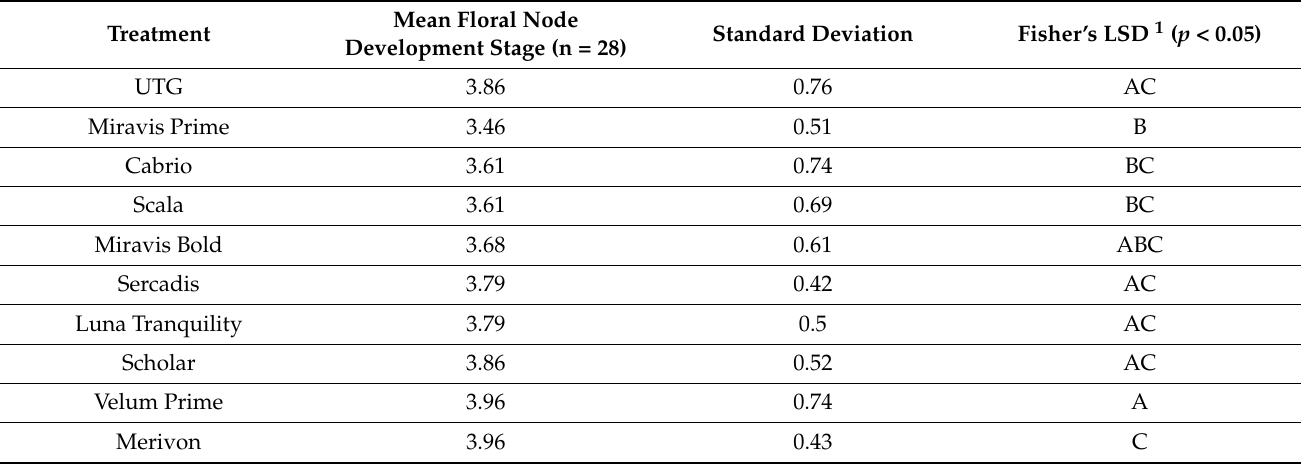
Table 2. Differing floral bud development stages by treatment group. Differing letters